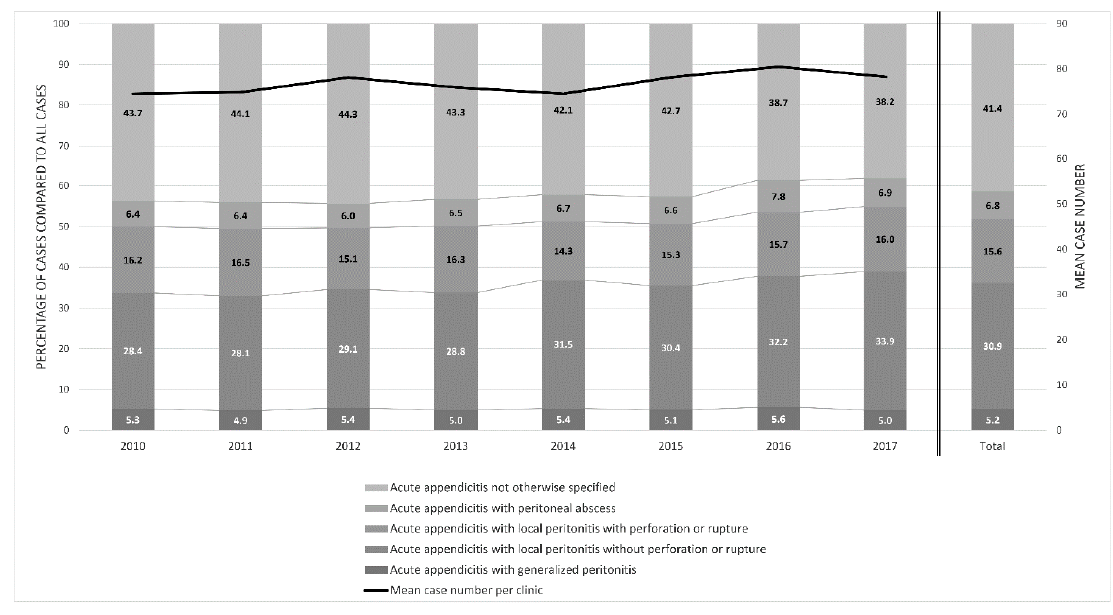
Figure 7. Distribution of cases with a main diagnosis of acute appendicitis by type of appendicitis (according to the ICD-10 guideline) between 2010 and 2017 ( n = 19,749).